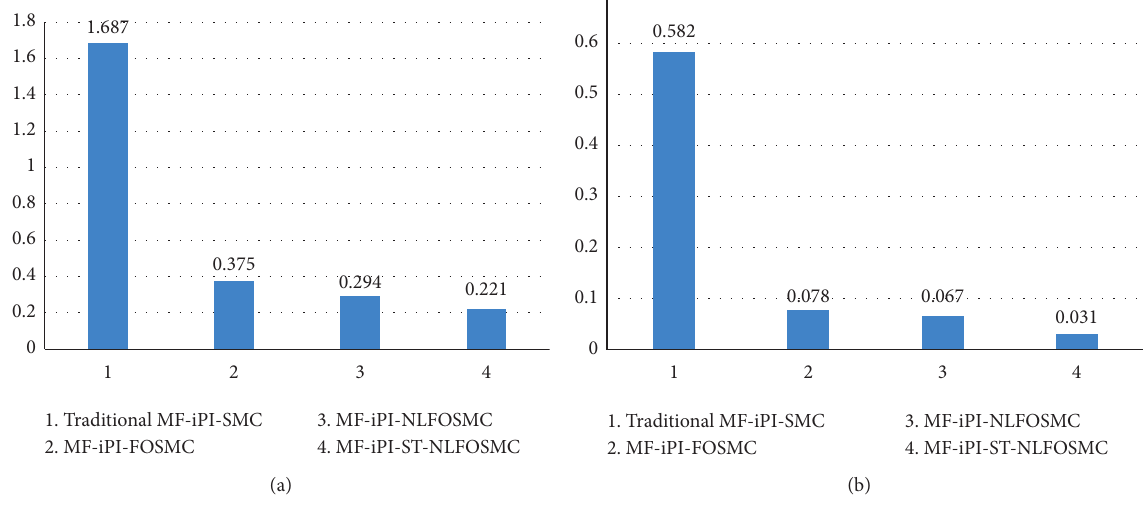
Figure 6: (a) Maximum absolute errors under the traditional MF-iPI-SMC, the MF-iPI-FOSMC, the MF-iPI-NLFOSMC, and the MF-iPI- ST-NLFOSMC without load. (b) Root-mean-square errors under the traditional MF-iPI-SMC, the MF-iPI-FOSMC, the MF-iPI- NLFOSMC, and the MF-iPI-ST-NLFOSMC without